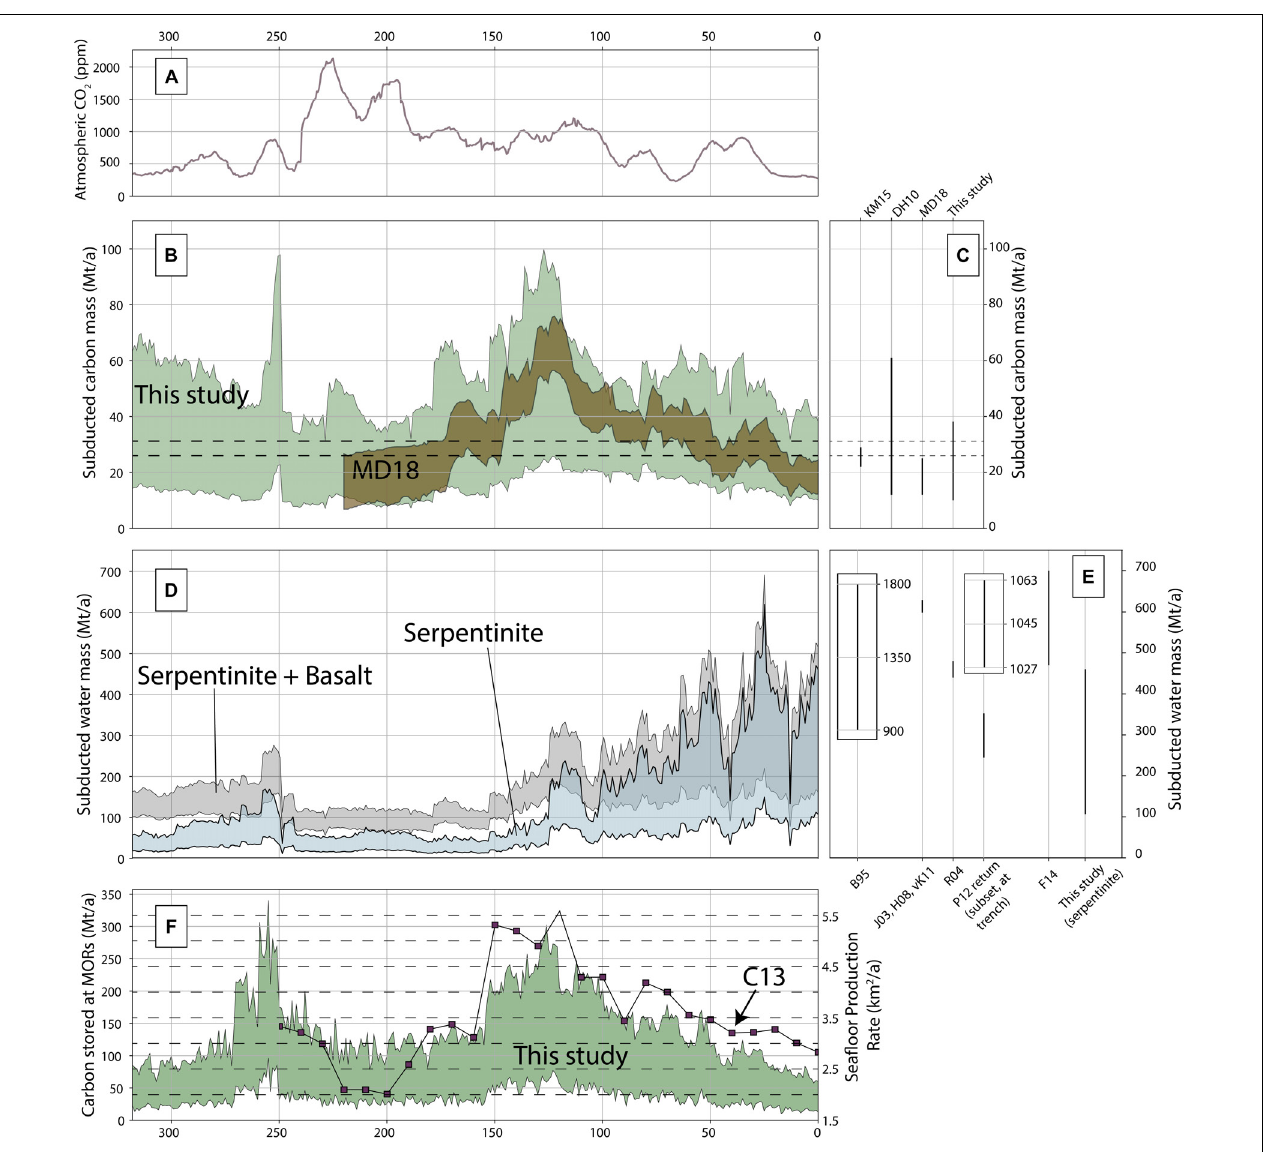
FIGURE 11 | (A) Atmospheric CO 2 after Foster et al. (2017). (B) Mass of carbon entering subduction zones according to our results (green) and Müller and Dutkiewicz (2018) (bronze, MD18). (C) Present-day estimates from other studies. KM15, Kelemen and Manning (2015); DH10, Dasgupta and Hirschmann (2010); MD18, Müller and Dutkiewicz (2018). (D) Mass of water stored in serpentinite and the upper volcanic layer entering subduction zones. (E) present-day estimates of water storage in oceanic crust; B95, Bebout (1995); J03, Jarrard (2003); R04, Rüpke et al. (2004); H08, Hacker (2008); vK11, van Keken et al. (2011); P12, return flow from Parai and Mukhopadhyay (2012) (inset is delivery to trench), and F14, Faccenda (2014). (F) Seafloor production rates after Coltice et al. (2013) for the past 250 Ma (purple squares, C13) and our estimates of carbon stored in upper oceanic lithosphere at mid-ocean ridges (green band).